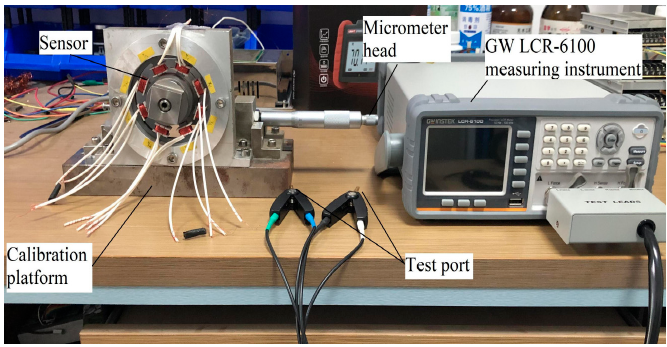
Figure 11. The static measurement experimental device.